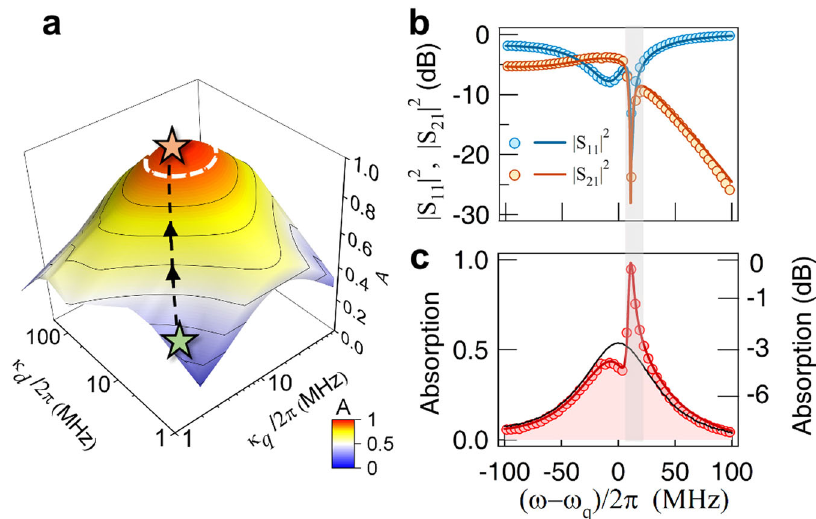
Fig. 4 Near-perfect absorption. a Theoretical calculation of the maximal absorption of our cavity magnonic device as a function of κ d and κ q . The white dashed line indicates the region in which the maximal absorption rate is over 90%. Green and yellow sparks indicate the parameters of the currently used and modi fi ed cross cavities, respectively. b Measured square of re fl ection ( ∣ S 11 ∣ 2 in blue circles) and transmission ( ∣ S 21 ∣ 2 in orange circles) of the modi fi ed cavity magnonic device, shown in dB scale. MIPA occurs when two dips coalesce. Correspondingly, the measured absorption spectrum is plotted in c in red circles, which shows enhancement compared with empty cavity absorption (black solid line). The measured maximal absorption rate is 96%. Solid orange and blue lines in b and red lines in c are results calculated by using Eq.